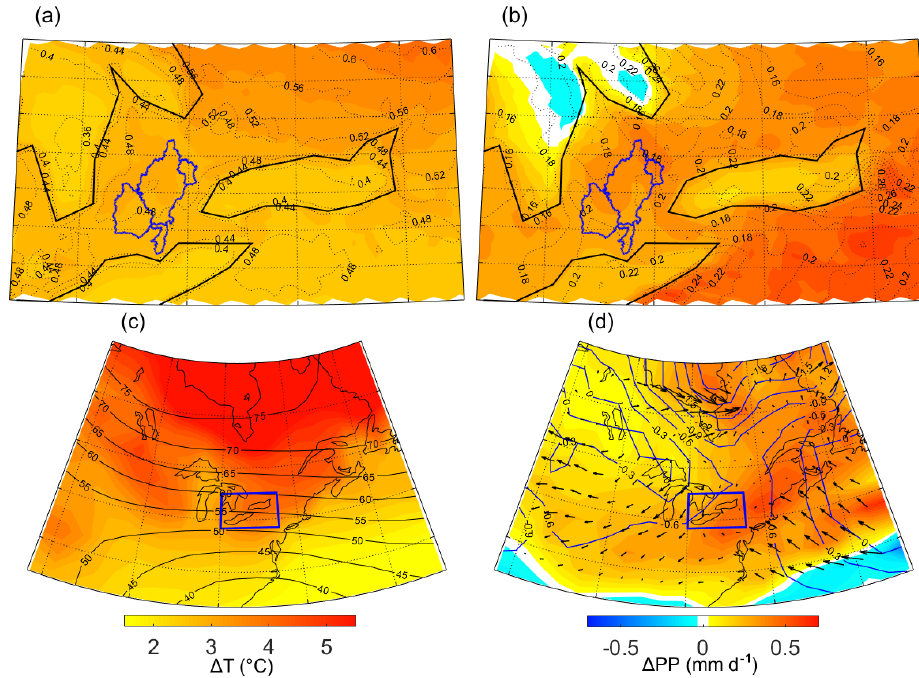
Figure 8. A 50-member ensemble average change of atmospheric conditions between the historical and the 2040s periods in January– February for (a) CRCM5-LE average surface temperature (shade) and standard deviation (black lines); (b) CRCM5-LE average daily pre- cipitation (shade) and standard deviation (black lines); (c) CanESM2-LE T 850 (shade) and Z 500 (black lines); and (d) CanESM2-LE daily precipitation (shade), SLP (blue lines) and wind